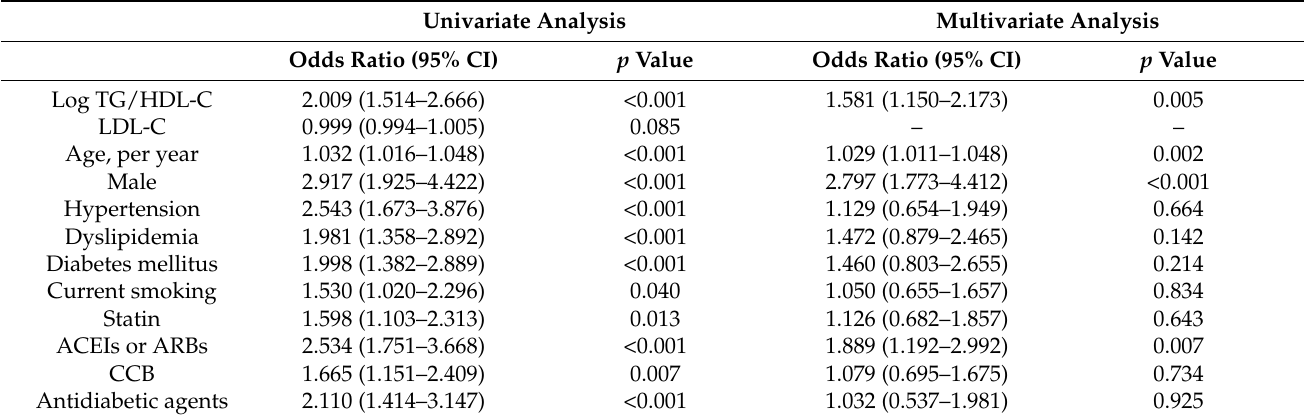
Table 3. Univariable and multivariable associates of high-risk plaques.